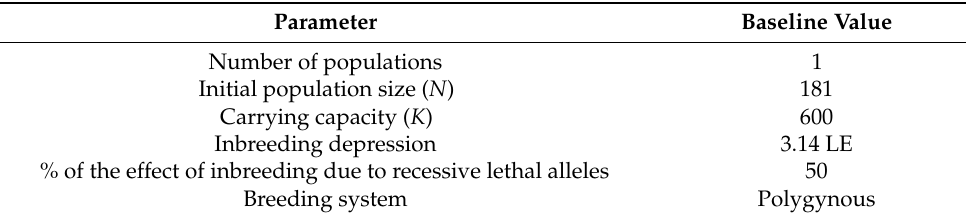
Figure 1. Map showing the distribution area of YFP in the 180-km-long section of the Yangtze River, between Hukou and Meilong. Table 1. Summary of parameter input values used in the VORTEX baseline model for YFP population in